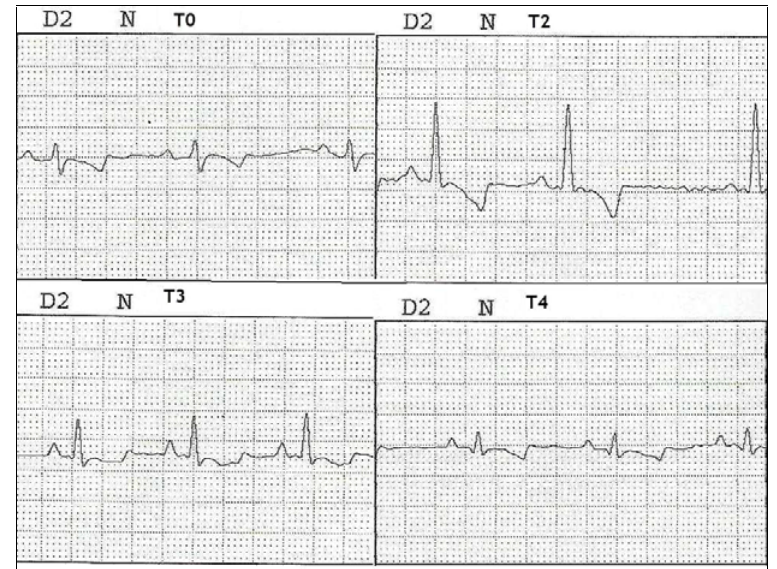
Figure 7: Electrocardiographic tracings at D2 lead, speed of 50 mm/s, and N sensibility (1cm = 1mV) of G1 animal (0.25 mg/kg) at the four moments studied (T0 = pre-envenomation; T2 = 6h after envenomation; T3 = 24h after envenomation; and T4 = 72h after envenomation). Botucatu, São Paulo, Brazil,